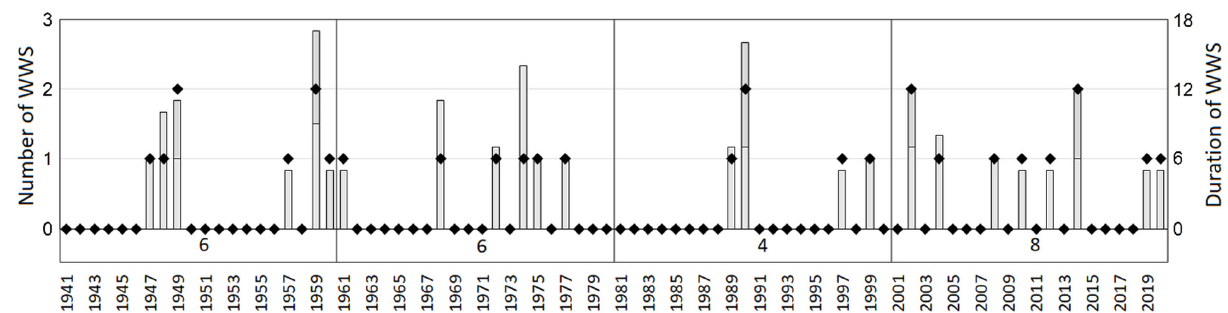
Figure 4. Frequency (left vertical axis, diamonds) and duration (right vertical axis, bars) of winter warm spells recorded throughout the 80-year period of meteorological measurements at the Skalnat é Pleso Observatory